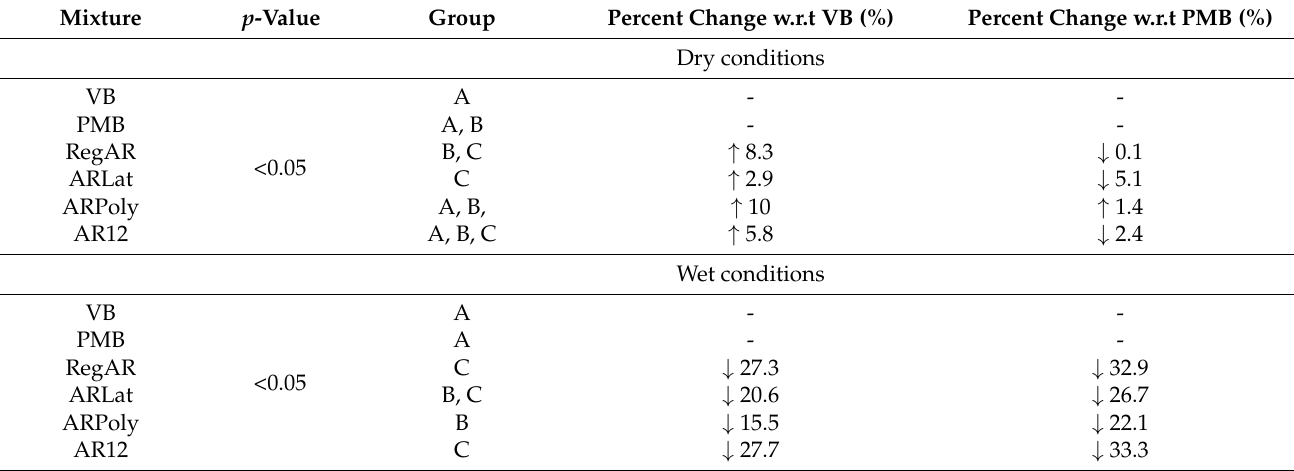
Table 6. Results of ANOVA analysis for indirect tensile strength (parametric test).